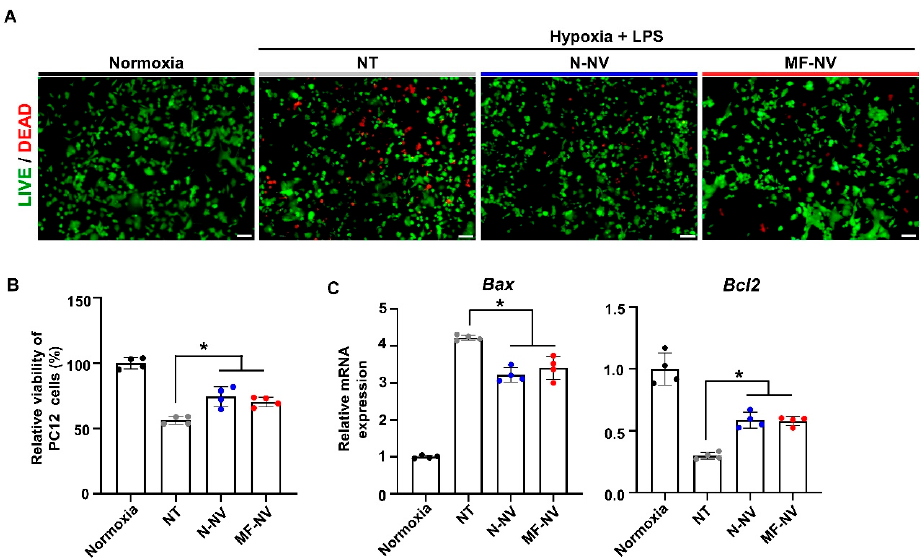
Figure 3. In vitro neuroprotective effects of NVs. ( A ) Representative images of viable and nonviable PC12 cells stained by fluorescein diacetate (FDA) / ethidium bromide (EB) after treatment. Scale bars, 100 µ m. ( B ) Relative cell viability as evaluated by the CCK assay after the treatment (n = 4 per group). ( C ) Relative mRNA expression levels of apoptotic ( Bax ) and anti-apoptotic ( Bcl2 ) genes in PC12 cells after treatment, as evaluated by qRT-PCR (n = 4 per group). NT indicates no treatment. * p < 0.05 by using one-way ANOVA followed by post-hoc Bonferroni test. All values are mean ± SD.